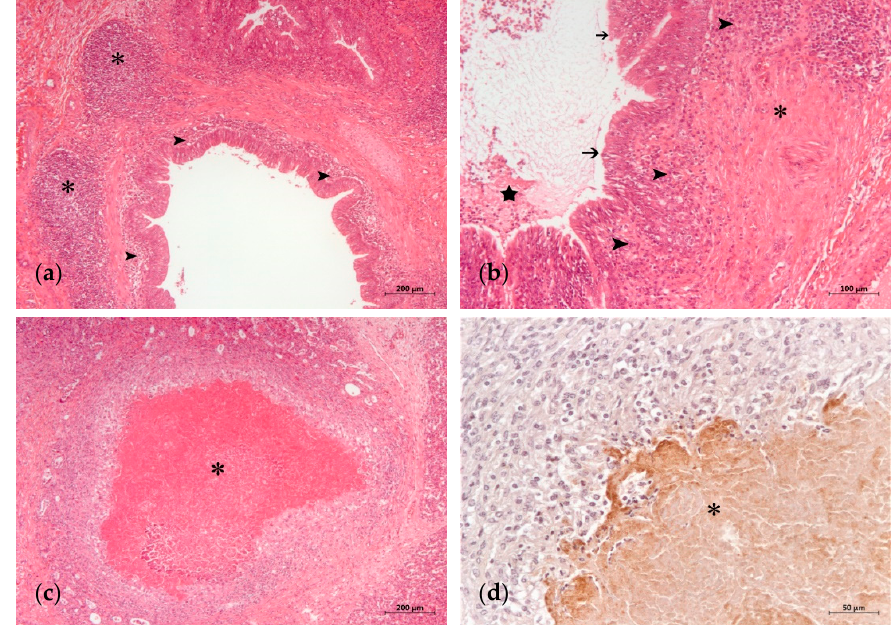
Figure 2. Advanced histopathological lung lesions in a calf with M. bovis infection: ( a ) prominent BALT hyperplasia (asterisks) and bronchitis (arrowheads) (H-E); ( b ) abundant mucopurulent exudate in the lumen of a bronchiole (star), fibrosis (asterisk) of the wall along with mononuclear inflammatory infiltrate (arrowhead) and necrosis of the epithelial surface (arrows) (H-E); ( c ) extended caseonecrotic focus (asterisk) with eosinophilic center demarcated by inflammatory cells, remnants of necrotic bronchiolar epithelium and fibrosis (H-E); ( d ) detail of caseonecrotic focus (asterisk) with granular M. bovis antigen predominantly at the periphery (IHC).